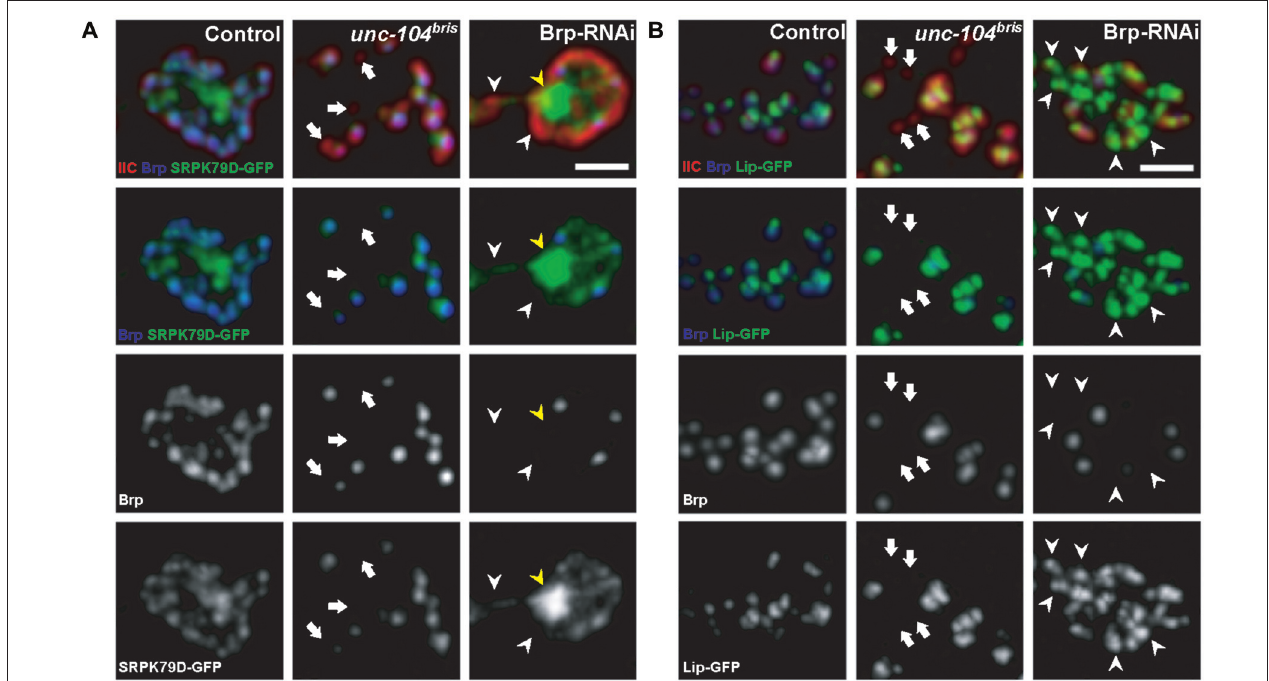
FIGURE 1 | Localization of presynaptic components at the neuromuscular junction (NMJ) of unc-104 bris mutant and Bruchpilot (Brp) RNAi expressing larvae. (A,B) Synaptic bouton at the NMJ costained with antibodies against postsynaptic glutamate receptor subunit IIC (GluRIIC, red in upper panel) and presynaptic Brp (blue in upper panel, gray in 3rd panel). Clustering pattern of GFP-tagged serine-arginine protein kinase at 79D (SRPK79D-GFP; A ) and Liprin- α (Lip-GFP; B ) respectively in synaptic bouton. (A) SRPK79D-GFP did not concentrate at Brp negative (Brp − ) synapses in unc-104 bris mutants (arrows). At the NMJ of larvae expressing BRP RNAi pan-neuronally (Brp-RNAi), SRPK79D-GFP failed to concentrate at Brp − synapses (white arrowheads) and large aggregation of SRPK79D-GFP is evident in the bouton (yellow arrowheads). (B) Lip-GFP does not localize to Brp − synapses in unc-104 bris larvae (arrows), whereas in Brp-RNAi animals Lip-GFP is present at Brp − synapses (white arrowheads). Genotypes in (A) : control ( elavX-Gal4/+ ;; UAS-Srpk79d-GFP/+ ), unc-104 bris ( elavX-Gal4/+ ; unc-104 bris /unc-104 d 11024 ; UAS-Srpk79d-GFP/+ ), Brp-RNAi ( elavX-Gal4/+ ;; UAS-Srpk79d-GFP/UAS-Brp-RNAi ). Genotypes in (B) : control ( elavX-Gal4/+ ;; PP2A-Lip-GFP/+ ), unc-104 bris ( elavX-Gal4/+ ;unc -104 bris /unc-104 d 11024 ; PP2A-Lip-GFP/+ ), Brp-RNAi ( elavX-Gal4/+ ;; PP2A-Lip-GFP/UAS-Brp-RNAi) . Experiments were performed at 29 ◦ C. Scale bars: 2 µ